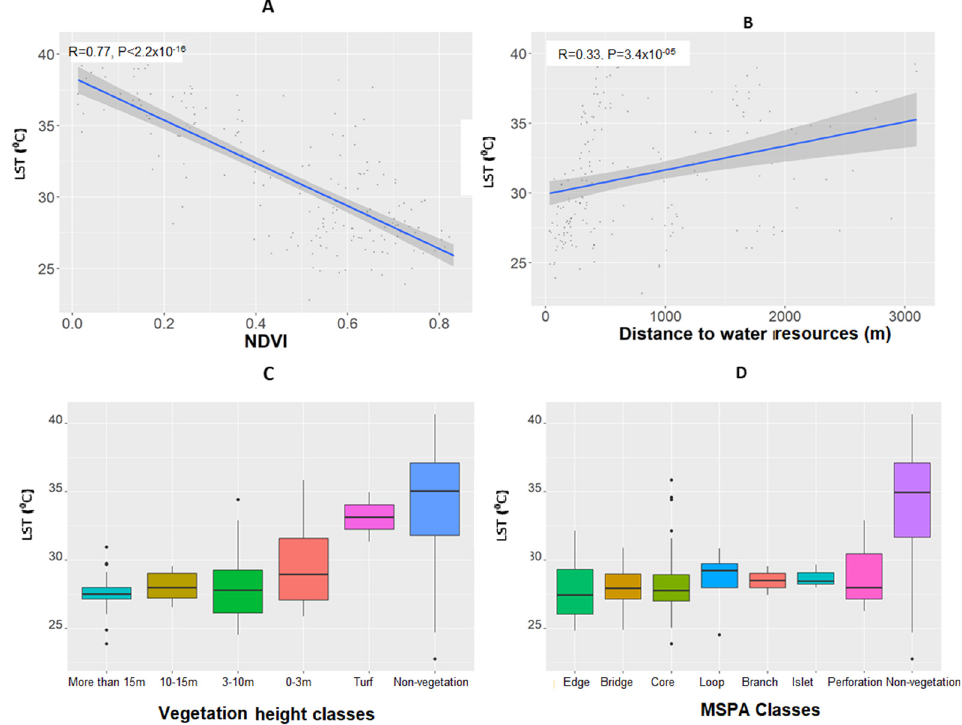
Figure 5. Factors affecting Land Surface Temperature: ( A ) Relationship between LST and NDVI; ( B ) Relationship between LST and distance to the water resources; ( C ) Variation in LST among vegetation height classes; ( D ) Variation in LST among MSPA classes.